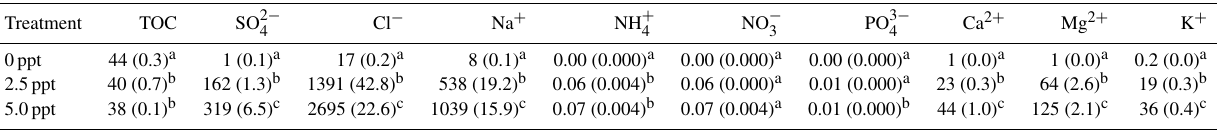
Table 1. Total organic C (TOC) and ion concentrations (mgL − 1 ) in freshwater (0ppt), 2.5ppt saltwater, and 5.0ppt saltwater. Standard errors of the mean are in parentheses ( n = 4). Values with different superscript lowercase letters are significantly different ( P < 0 . 05).